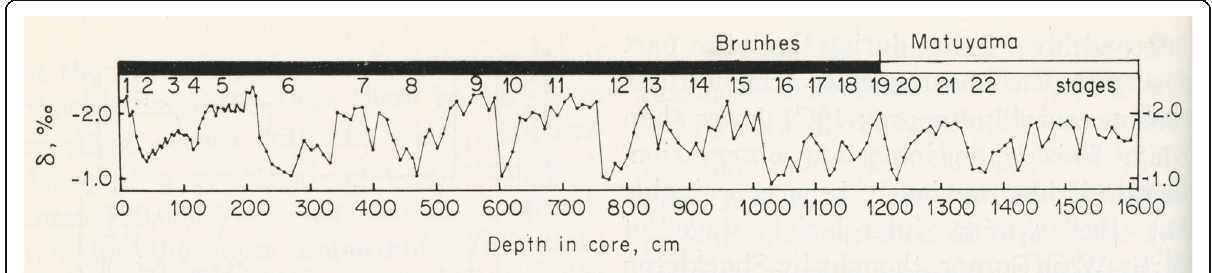
Fig. 6 Reproduction of fig. 9 in Shackleton and Opdyke (1973) showing the δ 18 O record of the planktonic foraminifera Globigerinoides sacculifer a from core V28-238, western equatorial Pacific, from which MIS 19 was defined for the first time (Shackleton and Opdyke 1973). This study confirms the links between MIS 19, carbonate cycle B17 of Hays et al. (1969), and the Matuyama – Brunhes paleomagnetic